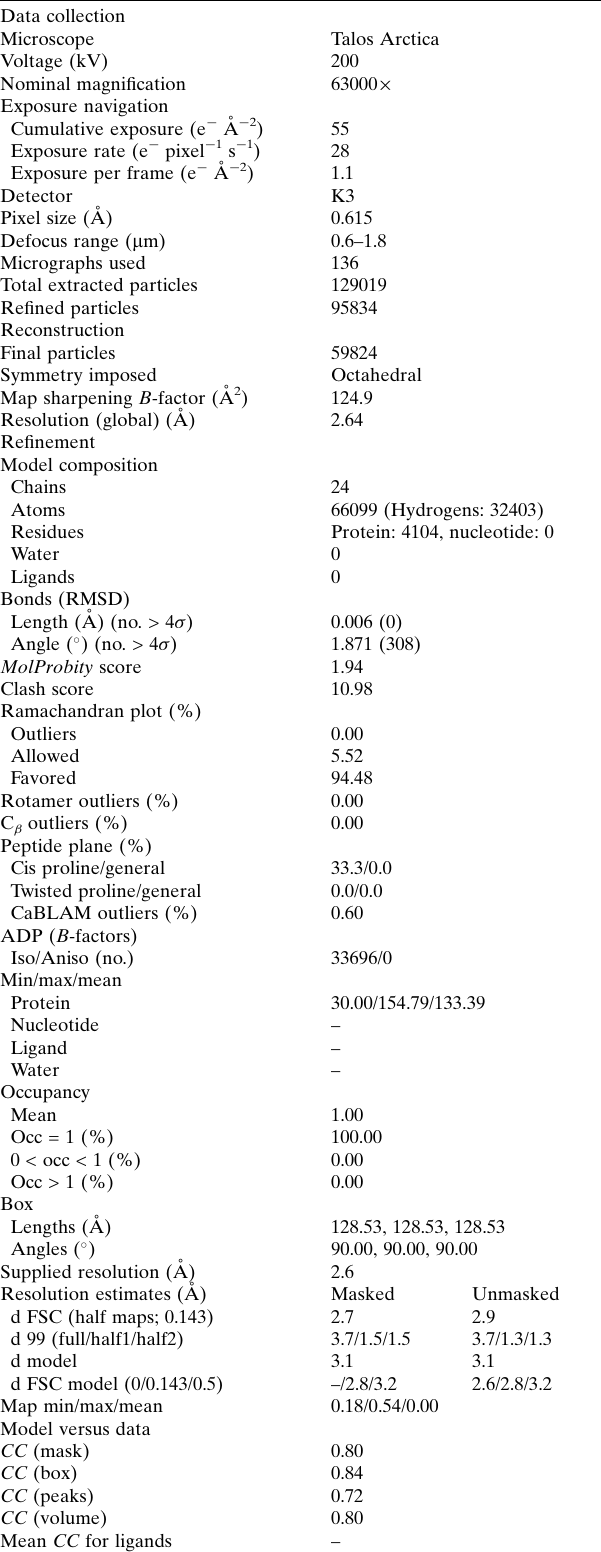
Table 1 Refinement statistics for an apoferritin structure determined using a